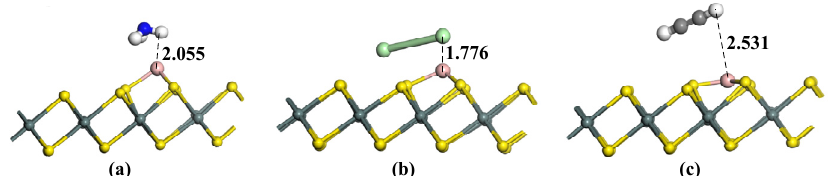
Figure 4. Gas adsorption on B-SnS 2 . ( a ) B-SnS 2 /NH 3 , ( b ) B-SnS 2 /Cl 2 , ( c ) B-SnS 2 /C 2 H 2 . The distance is Å. Table 2. Adsorption parameters of gas molecules on B-SnS 2 .